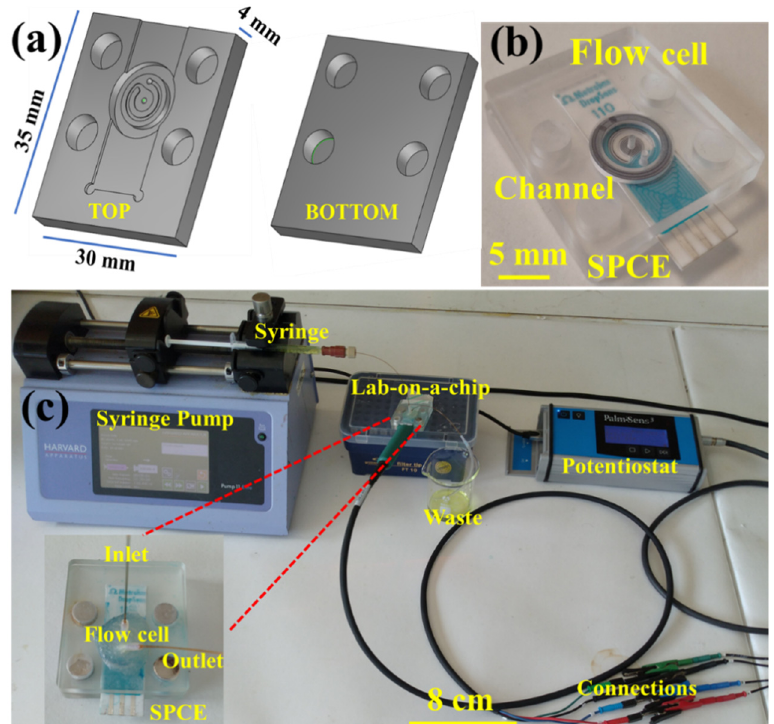
Figure 1. ( a , b ) Details of the microfluidic flow cell design. The top poly(methyl methacrylate) (PMMA) plate featured a groove to house the carbon-coated screen-printed electrode (SPCE), a spiral channel to move liquid over the working electrode surface with inlet an outlet holes, as well as four circular grooves to house the NdFeB magnets for clamping. The bottom plate was flat apart from the four magnet holding recesses. ( c ) Photograph of the experimental setup showing the syringe pump and collection vessel for fluid movement through the microfluidic flow cell with integrated SPCE electrode connected to a small potentiostat for recording of electrochemical measurements.